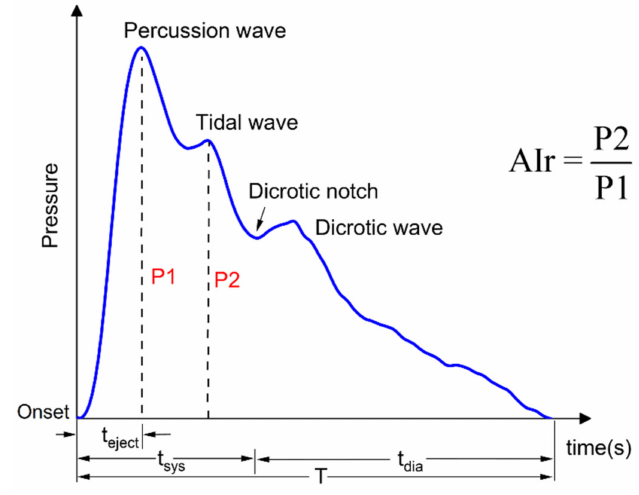
Figure 8. A typical pulse wave.